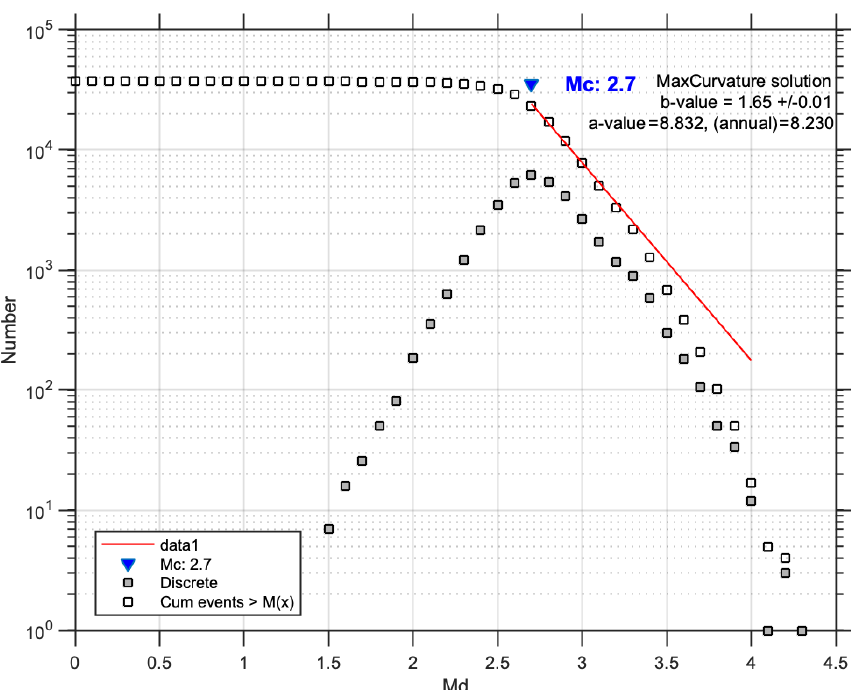
Figure 7. Frequency-magnitude distribution of the catalog in between the time interval 1 January 2008–31 December 2011 with magnitude of completeness M c =